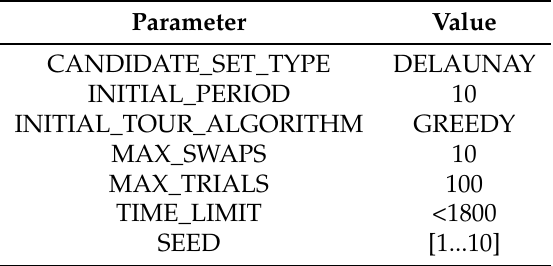
Table 10. Required parameter settings for LKH for solving large instances within half an